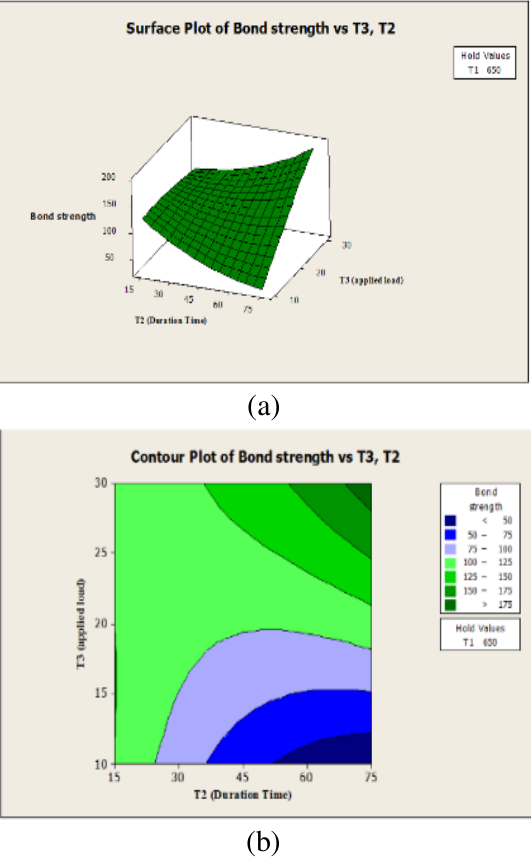
Fig. 7. Effects of time and applied stress on bond strength (a) 3D surface plot (b) 2D contour